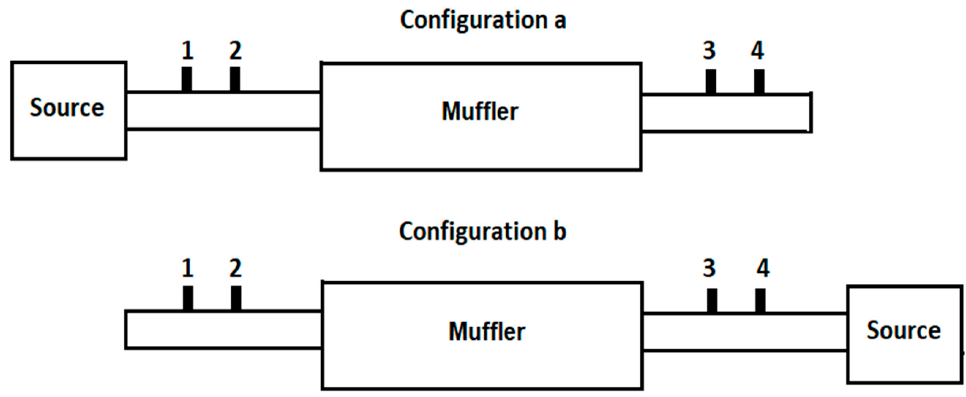
Figure 2. Measurement set-up according to the two-source method.